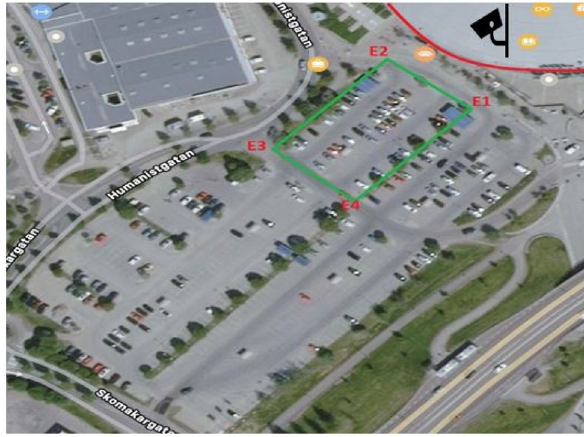
Figure 1: Observed parking lot and the region of interest highlighted by the green